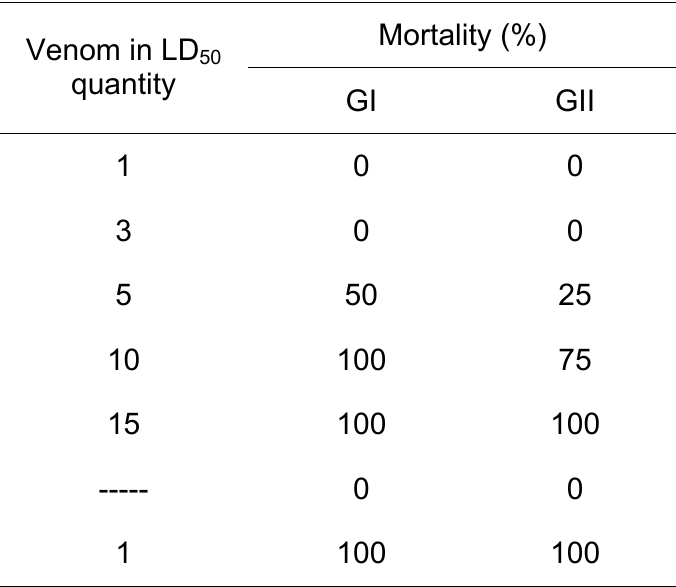
Table 1: Determination of the potency of Crotalus durissus terrificus antivenom prepared with native venom (GI) or irradiated venom (GII)